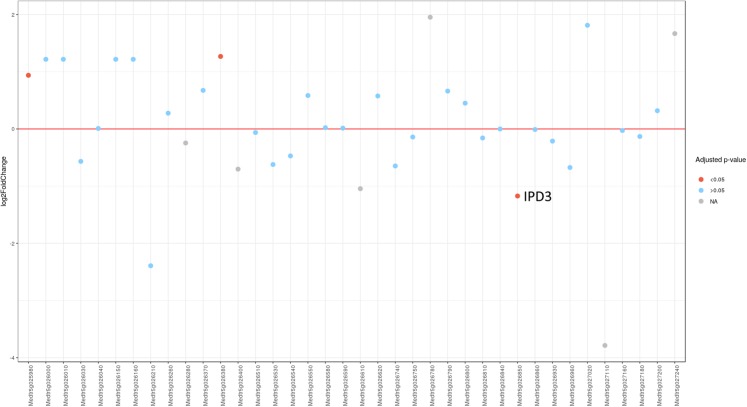
Differential expression of pea Sym11 candidate genes.Pea Sym11 candidate genes were chosen as homolog of Mt genes located in the defined genome region (see text). Each tick on the x axis represents a single pea transcript corresponding to Mt gene, which names are present on the x axis. Y axis represents the log2 fold change of gene expression in Fix− in relation to Fix+ MACE libraries. Colors represent the adjusted p-value as calculated by the DESeq2 package (red < 0.05, blue > 0.05, gray—not calculated p-value). The only significant gene lying in the determined boundaries and with significantly lower expression in mutant nodules is pea homolog of IPD3 (i.e., Sym33).